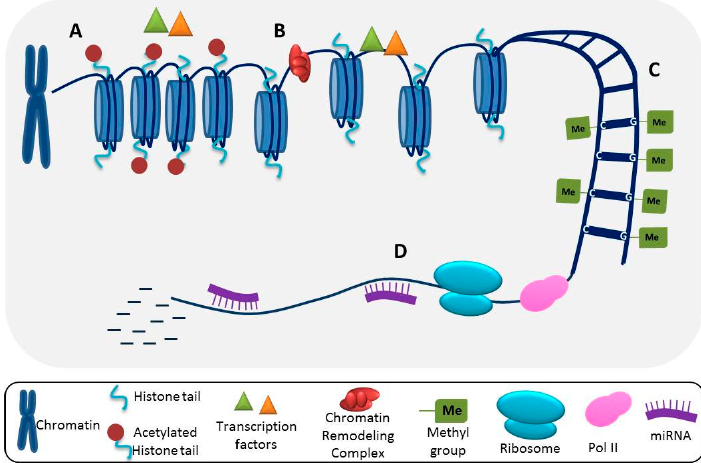
Figure 4. Several epigenetic mechanisms can lead to altered gene expression in tumor cells. ( A ) Histone acetylation results in tightly wound chromatin and inaccessibility of transcription factors to DNA; ( B ) Histone deacetylation and chromatin remodeling complexes promote the unwinding of chromatin complexes, allowing for transcriptional upregulation; ( C ) DNA can be methylated on C and G residues, which can lead to transcriptional repression; ( D ) Following transcription initiation by RNA polymerase II (Pol II), miRNAs can prevent protein translation by either blocking translocation of ribosomes down the mRNA transcript or by directing mRNA degradation.